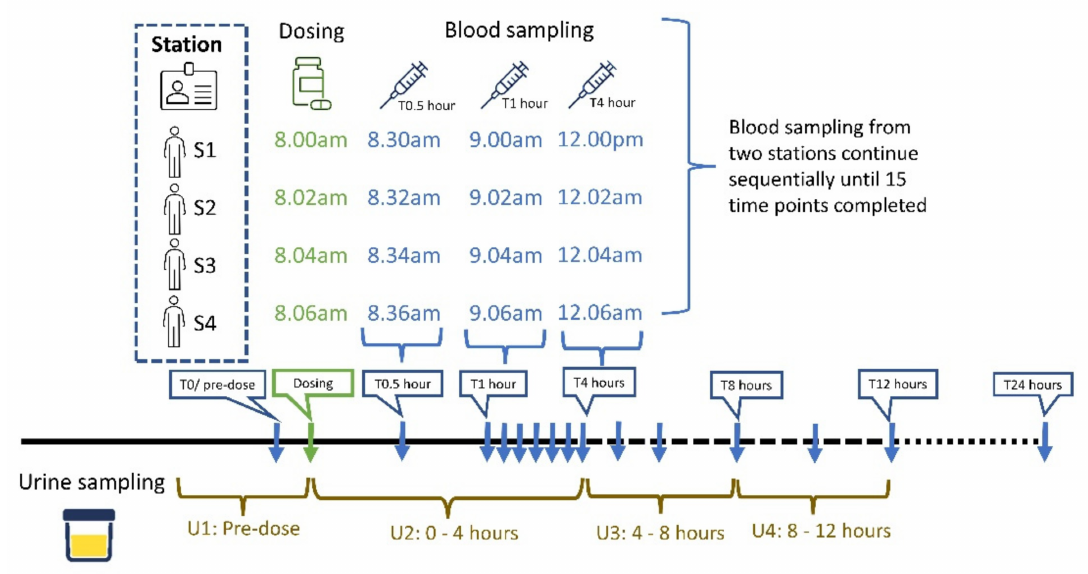
Figure 3. The diagram for dosing time, blood sampling, and urine sampling times in each